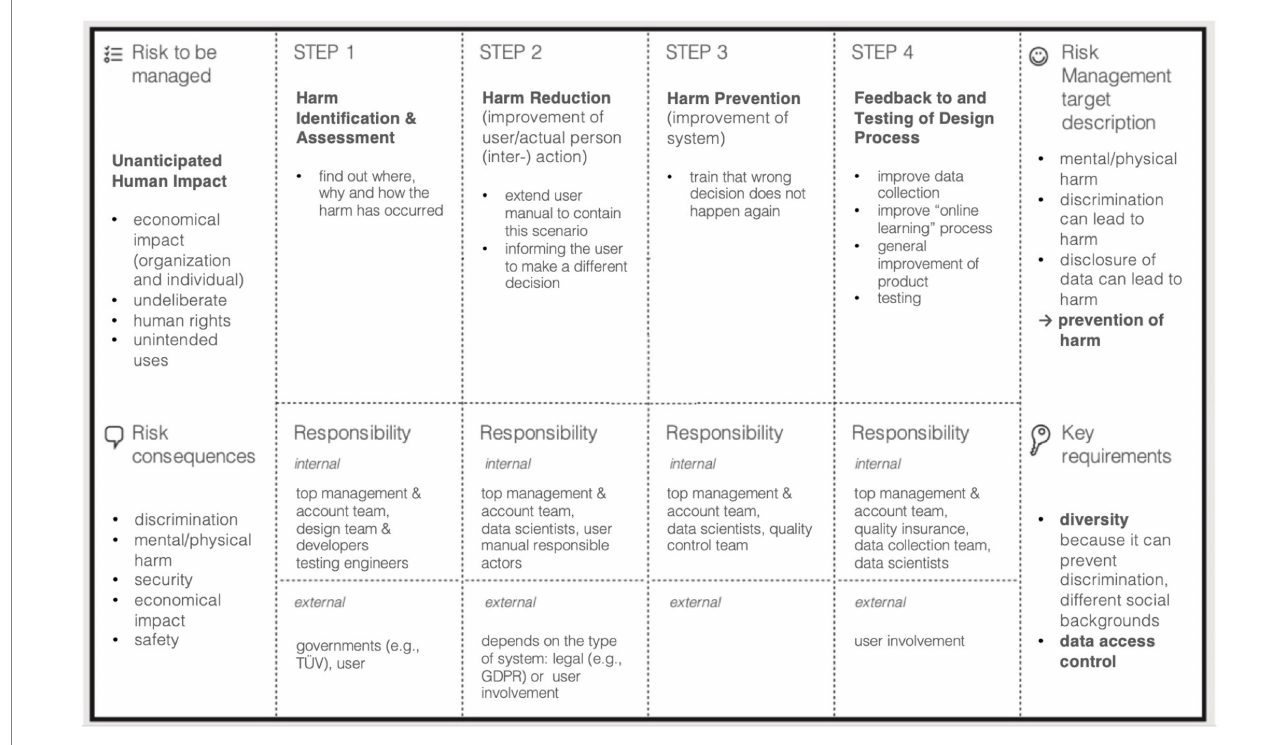
FIGURE 10 One of the prototyping canvases created during the workshop to exemplify the ideation process toward a reactive risk management